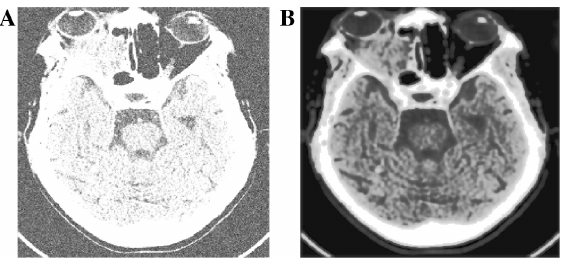
Figure 8: Analysis of Visual Quality of Restored Medical Image 1 (Gaussian Noise in σ = 50%). (A) Noisy image, (B) restored image.